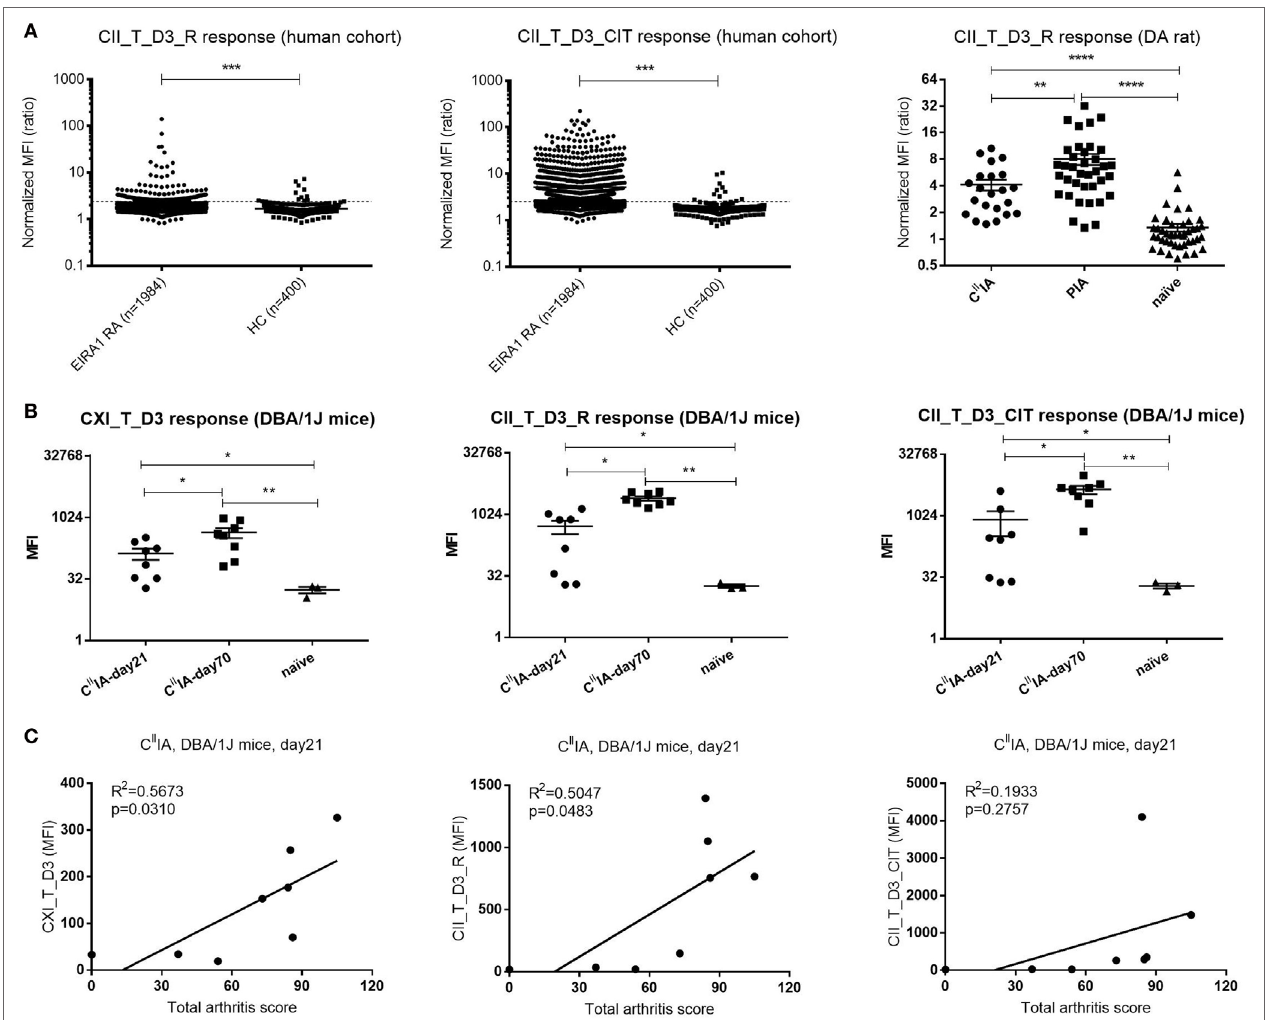
FigUre 6 | The D3 epitope response in Epidemiological Investigation of RA (EIRA) cohort and arthritic rodents, and the correlation between D3 epitope response and arthritis severity in C II IA mice. (a) IgG response of the (EIRA) cohort (rheumatoid arthritis: n = 1,984, HC: n = 142) to CII_T_D3_R and CII_T_D3_CIT (left and middle panel). The broken line indicates the cutoff (median + 5 × MAD) based on healthy controls. Anti-collagen antibody level against CII_T_D3_R peptide in C II IA ( n = 23), Pristane-induced arthritis model ( n = 37), and naïve ( n = 44) DA rats (right panel). Data are shown as normalized mean fluorescence intensity (MFI) ± SEM. (B) Anti-collagen antibody against CXI_T_D3, CII_T_D3_R and CII_T_D3_CIT in C II IA DBA/1J mice. (c) Correlation between serum antibody response to CXI_T_D3, CII_T_D3_R, and CII_T_D3_CIT and total arthritis score in C II IA mice. Statistics were determined by the Mann–Whitney U -test and Pearson correlation test for group comparison and correlation analysis,